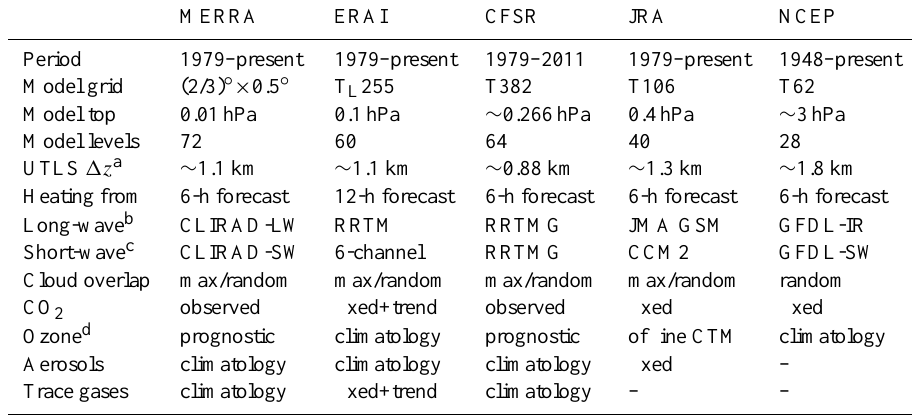
Table 1. Attributes of the reanalysis forecast models and radiation parameterisations.